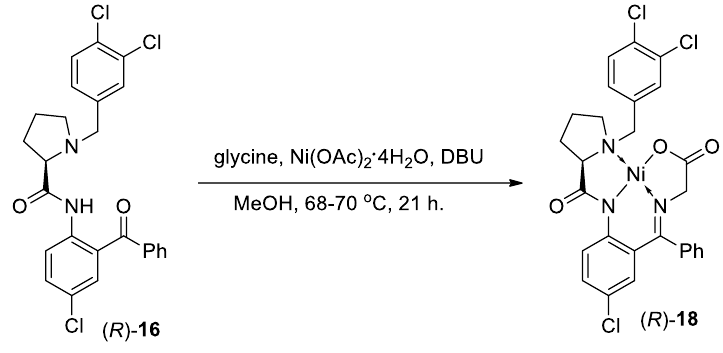
Scheme 3. Synthesis of Ni(II) complex 18 from 16 .